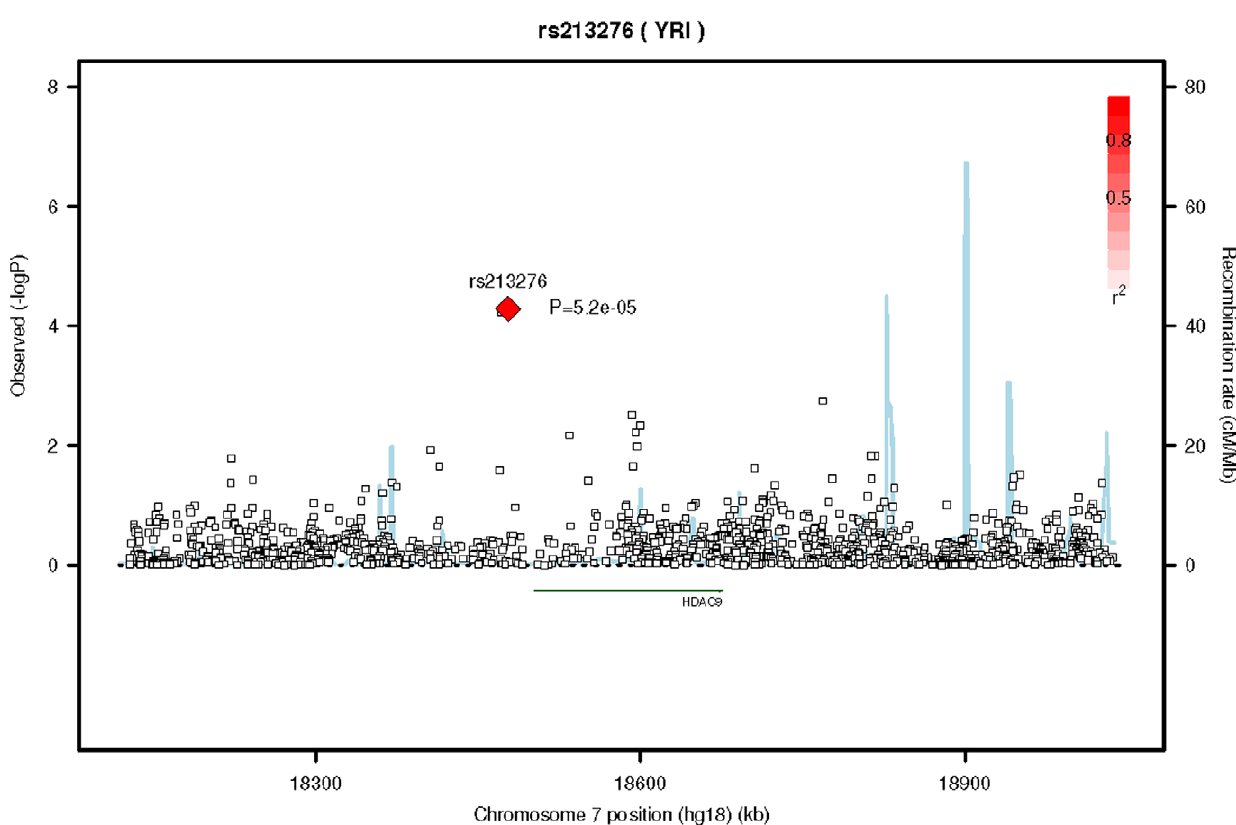
Figure 4. Regional association plot of SNP rs213276 on chromosome 7 for African Americans. This figure is the regional association plot of SNP rs213276 on chromosome 7 that reached gene-wide significance (p , 5.2 6 10 2 5 ) in the testing of transferability of the discovery SNP, rs12155400, to other SNPs in the histone deacetylase 9 gene in a cohort of African Americans without diabetes or hypertension. The lead and surrounding SNPs are color coded according to the pair-wise linkage disequilibrium (LD) with the lead SNP (presented as a diamond) on a scale of r 2 from 0 to 1. Estimated recombination rates reflect the local LD structure in the 500 kb buffer around the index SNP and plotted based on values from HapMap II Yoruba in Ibadan, Nigeria (YRI) population.